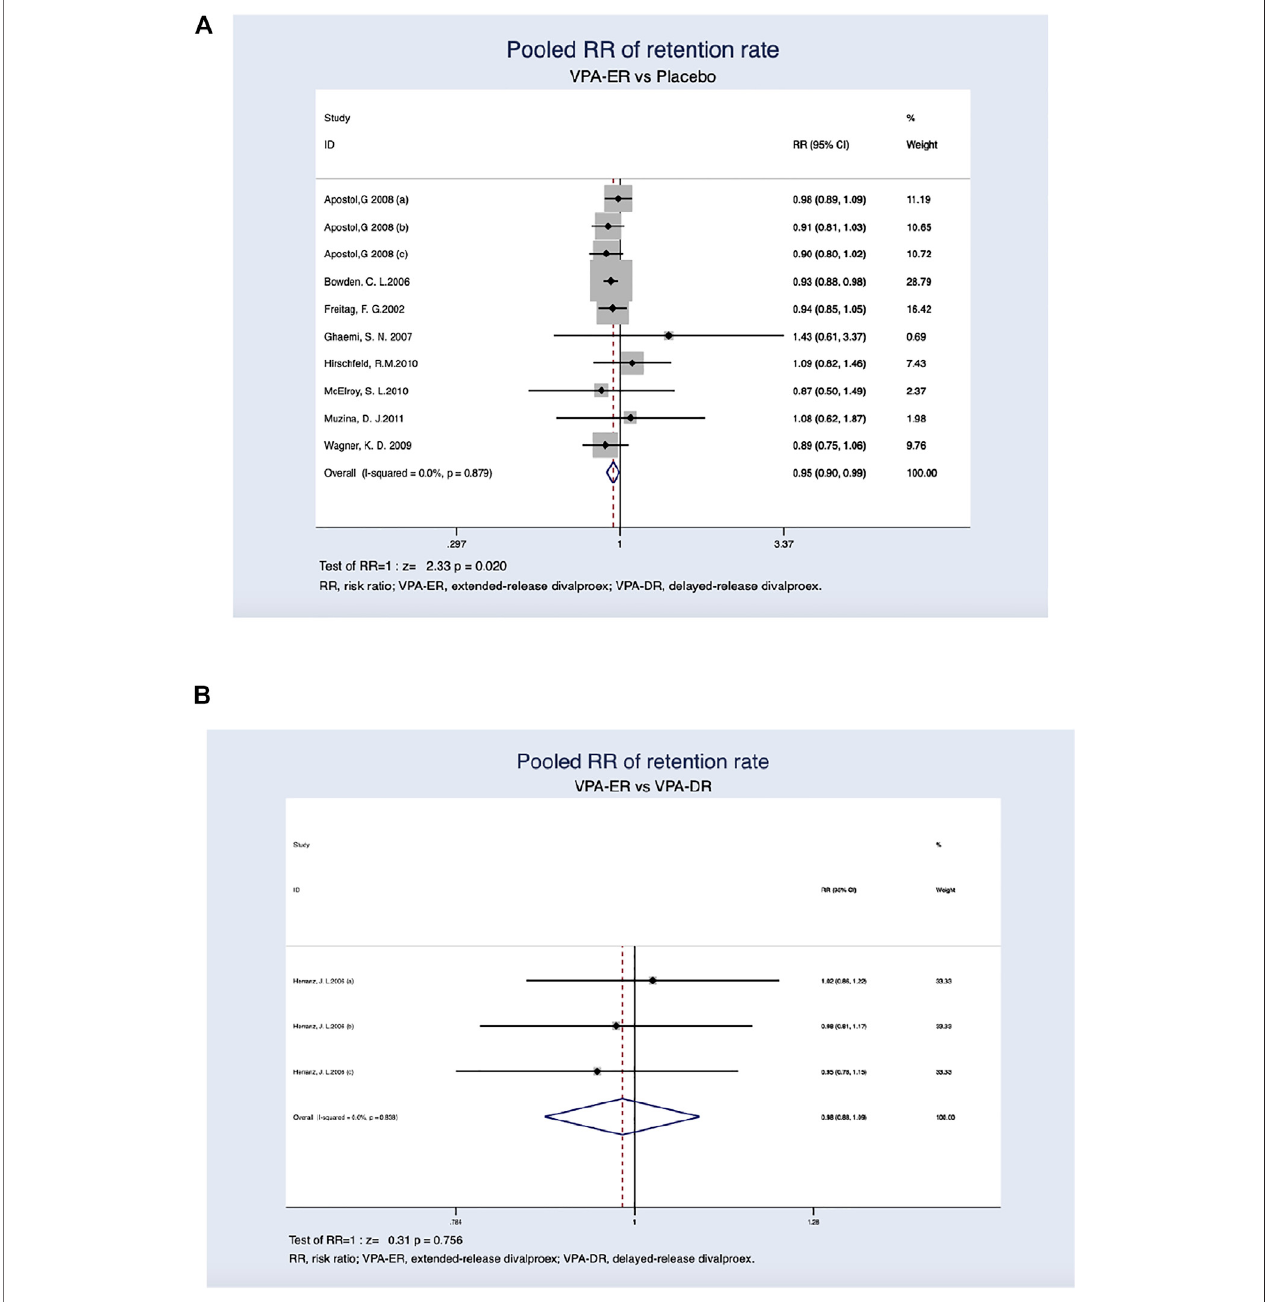
FIGURE 5 | (A) Pooled RR of retention rate between VPA-ER with placebo. (B) Pooled RR of retention rate between VPA-ER with VPA-DR.